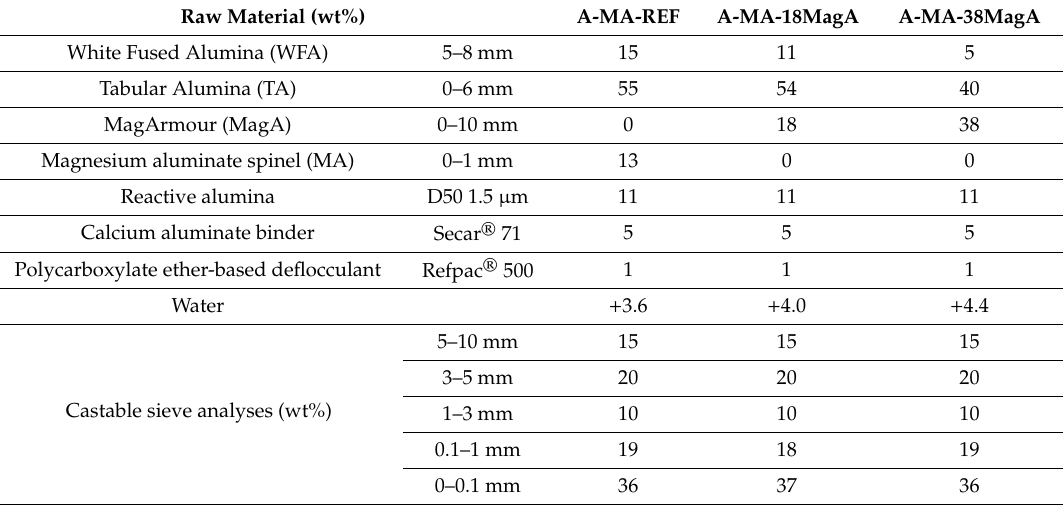
Table 2. Model castable formulations and granulometry.